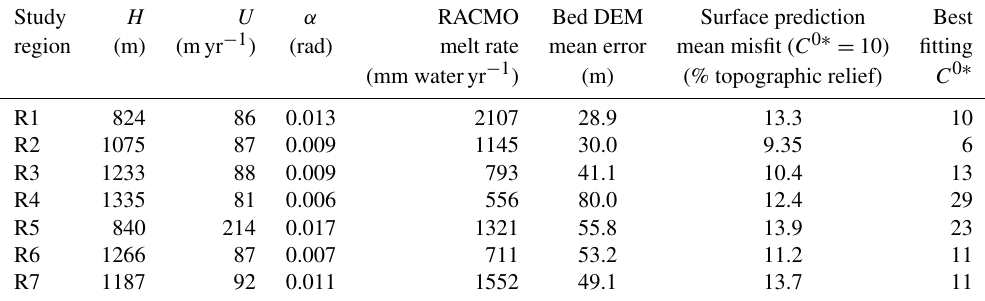
Table 1. Study region information (locations in Fig. 1a) and bed topography transfer function surface prediction results. We note that the mean misfit metric used here is not a comprehensive indicator of fit quality and that in regions R3–R5 and R6 surface topographic relief is significantly underpredicted. In all regions the transfer function surface predictions appear to be optimized with higher values of basal sliding than have been determined with other methods (MacGregor et al., 2016; Ryser et al., 2014b); we expect this is due to a combination of non-Newtonian rheology and poor bed DEM resolution. Study H U α RACMO Bed DEM Surface prediction Best region (m) (myr − 1 ) (rad) melt rate mean error mean misfit ( C 0 ∗ = 10) fitting (mm wateryr − 1 ) (m) (% topographic relief) C 0